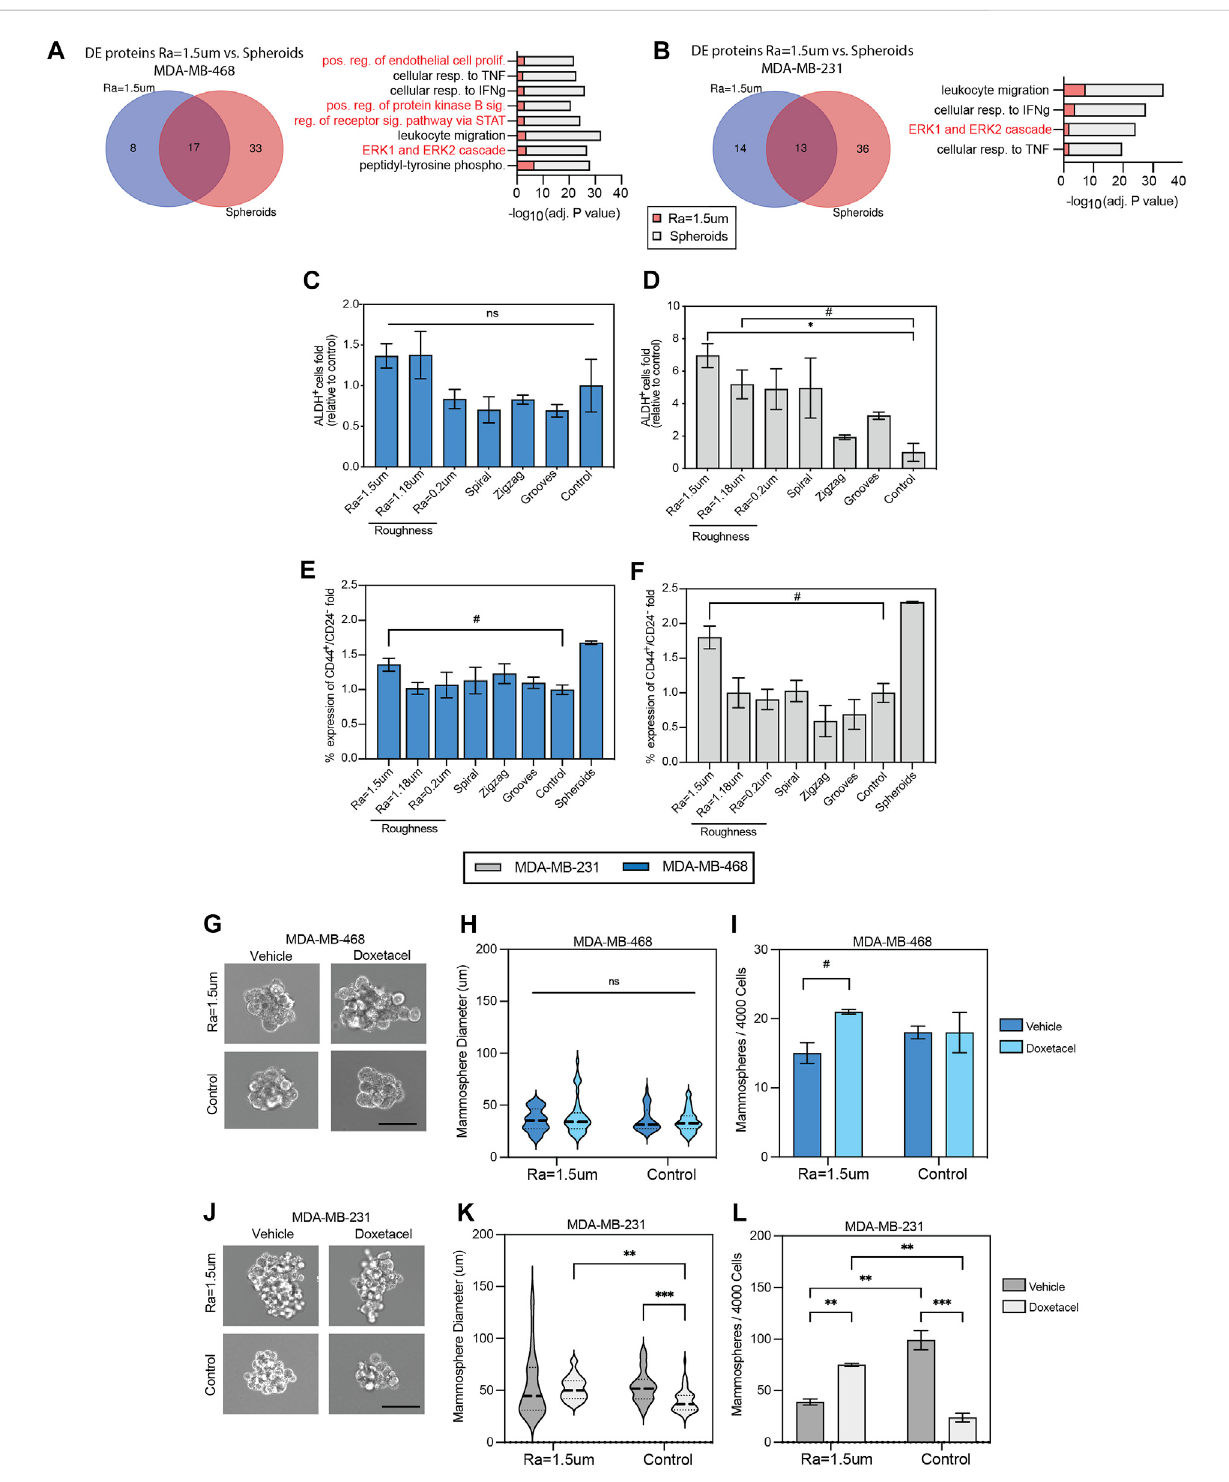
FIGURE 3 Surface roughness enhances thestemness ofTNBC cells. Summaryof differentially expressedproteins (foldchange > 2 relative to TCP)in (A) MDA- MB-468 and (B) MDA-MB-231 cells cultured in surfaces with roughness Ra = 1.5 µm compared to 3D modality (spheroids) as a positive control for oncogenicity with barplot of GO enriched bioprocesses in common between both conditions and pathways related to stemness highlighted in red. Quanti fi cation of aldehyde dehydrogenase (ALDH) positive cells in (C) MDA-MB-468 and (D) MDA-MB-231 cell lines by fl ow cytometry, relative to TCP control. Quanti fi cation of CD44 + /CD24 - subpopulations in (E) MDA-MB-468 and (F) MDA-MB-231 using fl ow cytometry, relative to TCP control. TNBC cells were cultured for 5 days in reduced serum (2% FBS) on the topographical substrates and TCP (control). (G) Representative images of MDA- MB-468 second generation mammospheres derived from cells cultured in rough surfaces and fl at TCP. Cells were treated with Vehicle (DMSO) or Docetaxel (10 µM) for 7 days. Scale bar: 25 µm. (H) MDA-MB-468 second generation mammosphere ’ s size distribution. (I) Number of